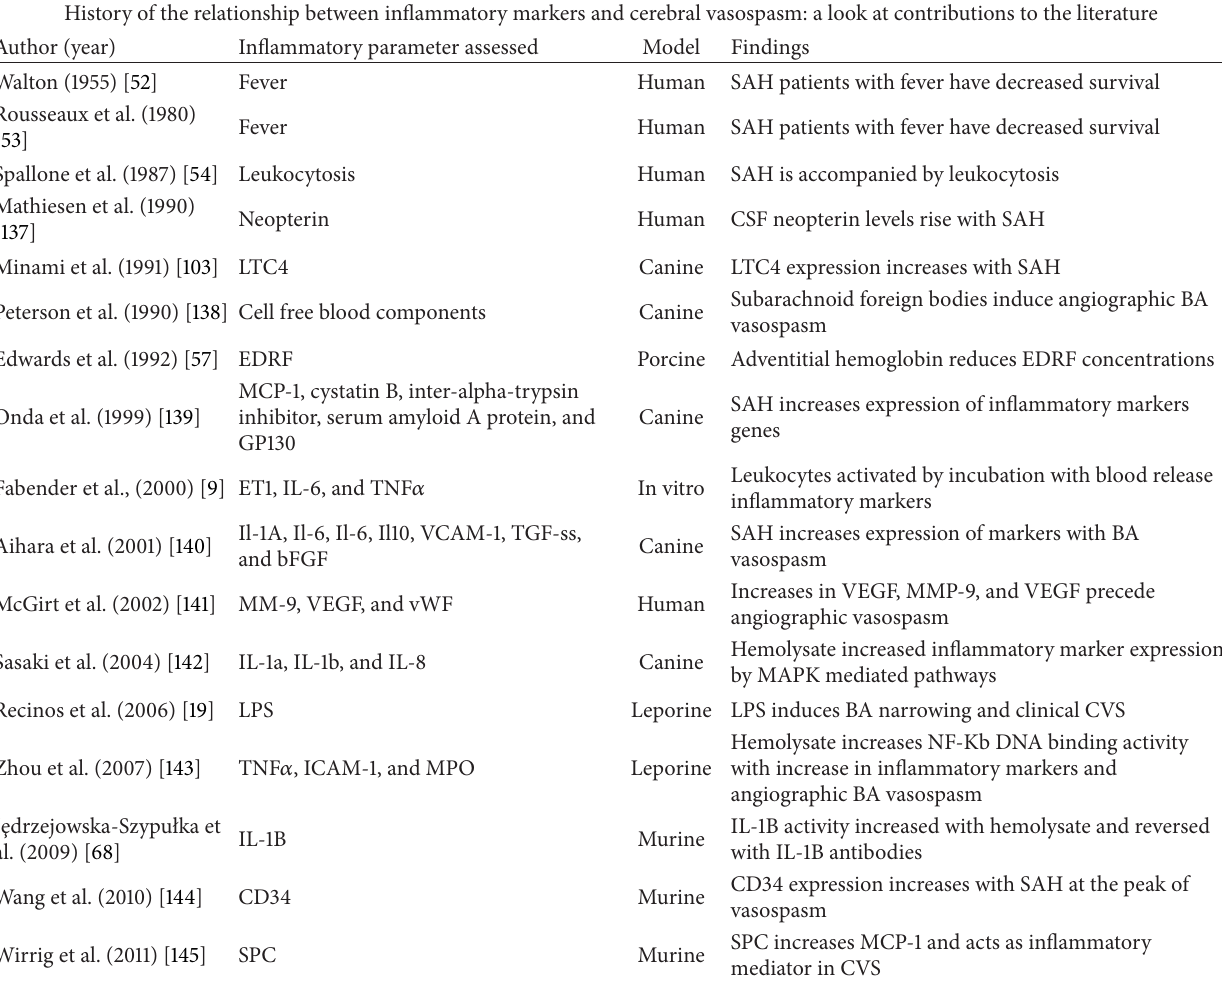
LTC4:leukotrieneC4,MCP-1:monocytechemotacticprotein1,ET1:endothelin1,TNF 𝛼 :tumornecrosisfactoralpha,MMP9:matrixmetalloproteinase,bFGF: basic fibroblast growth factor, EDRF: endothelium derived relaxing factor, IL1: interleukin 1, LPS: lipopolysaccharide, ICAM-1: intercellular adhesion molecule 1, MPO:myeloperoxidase, vWF:vonWillebrand’s factor,CD34: clusterof differentiation 34, SPC:sphyngosylphosphorylcholine, BA:basilar artery,and GP130: glycoprotein